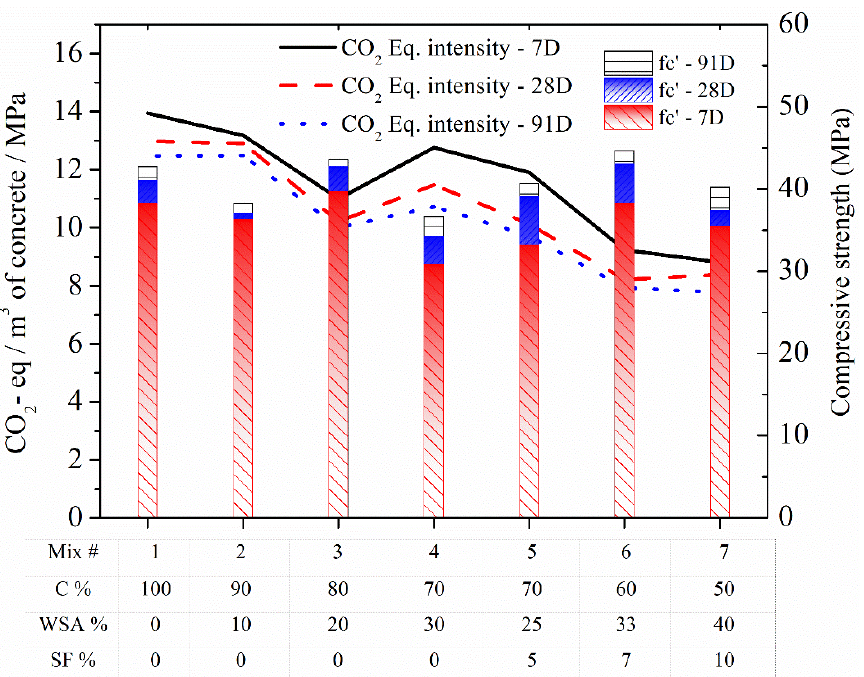
Figure 12. Comparison of normalized GWPs as kg CO 2 -eq with respect to strength among control, binary (C/WSA), and ternary (C/WSA/SF) concrete mixtures.